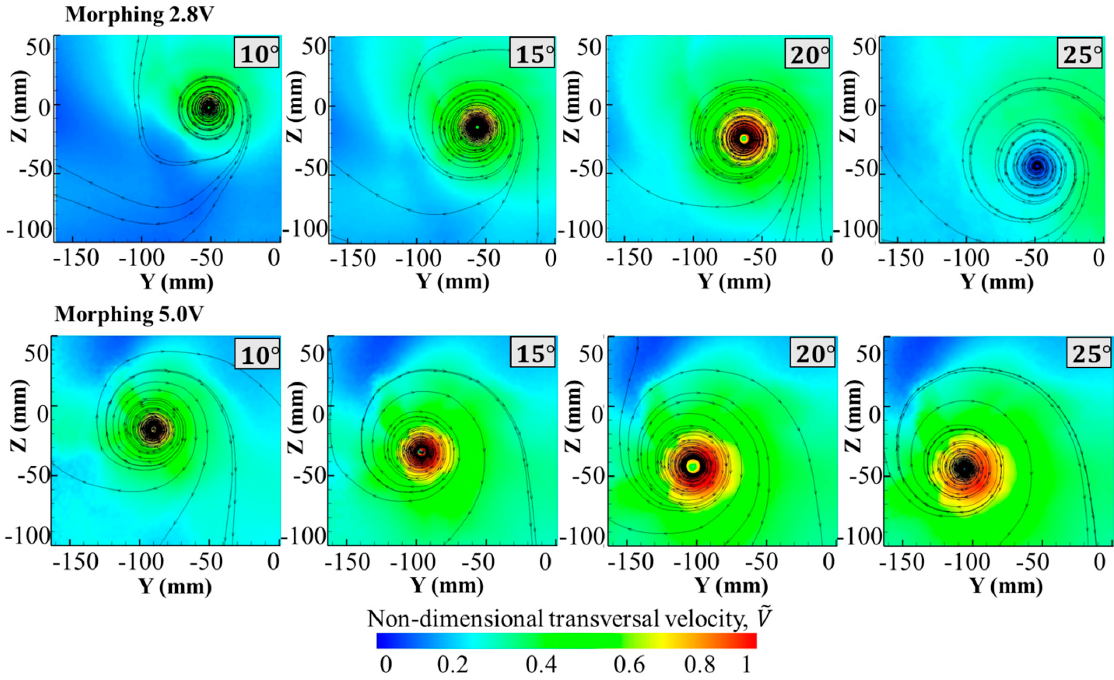
Figure 13. Non-dimensional transversal velocity maps for morphing 2.8 V and 5 V (wind tunnel data).